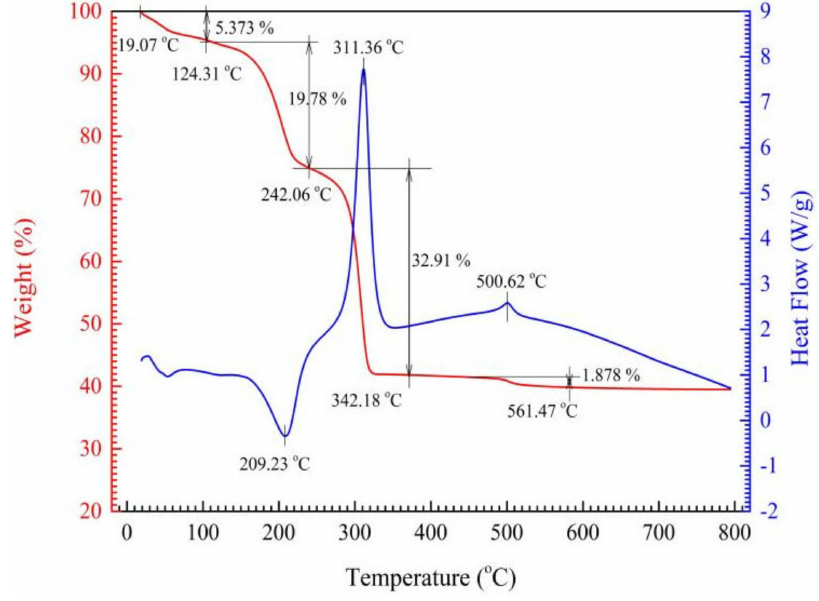
Figure 2. TG and DSC curves of S1 ceramic